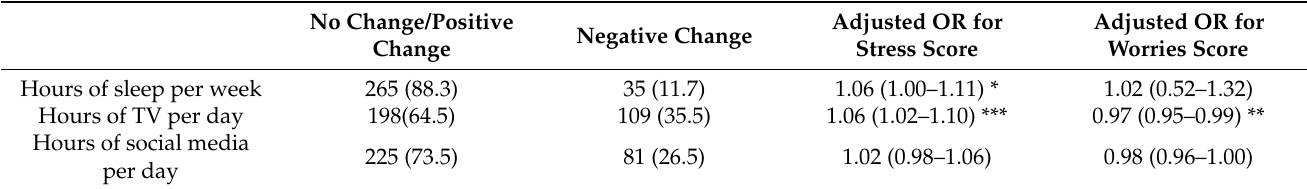
Table 6. Association between stress and worries and changes in functioning compared to 3months prior to pandemic ( N =